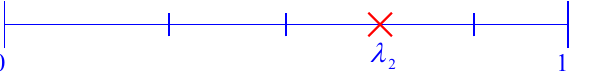
Figure 7: Example of the conditional probabilities in the Bell model for a measurement in C 4 . The unit interval is divided (cid:16)(cid:104) (cid:105) (cid:17) into 4 subintervals of length Tr . If λ 2 is in the jth φ j [ λ 1 ] interval then the outcome will be j. In the case depicted, the (cid:2) (cid:3) outcome is φ 2